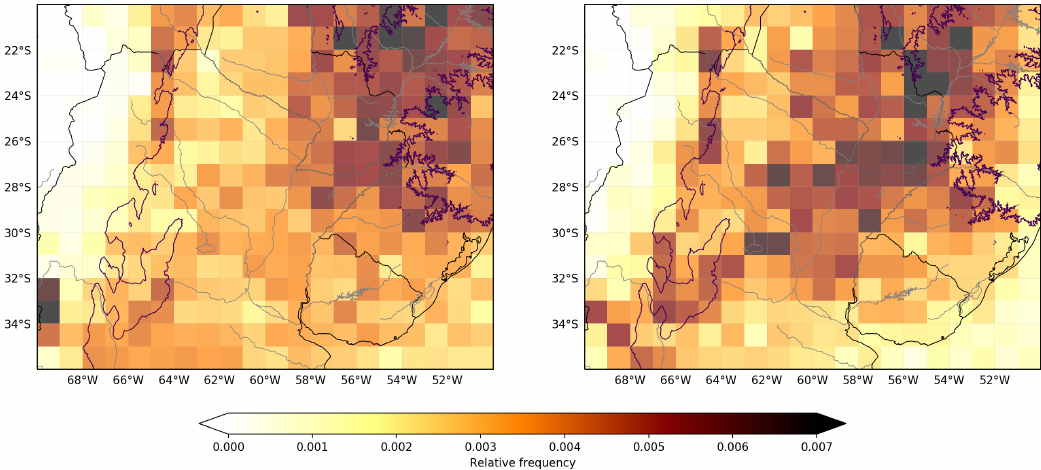
Figure 9. Relative frequency distribution in 1 ◦ × 1 ◦ boxes of the 99th percentile extreme Tropical Rainfall Measuring Mission (TRMM) rain precipitation features (RPFs) systems ( left panel ) and their estimated convective initiation areas ( right panel ). TRMM sampling bias is corrected by dividing each bin by TRMM 3A25 total pixel